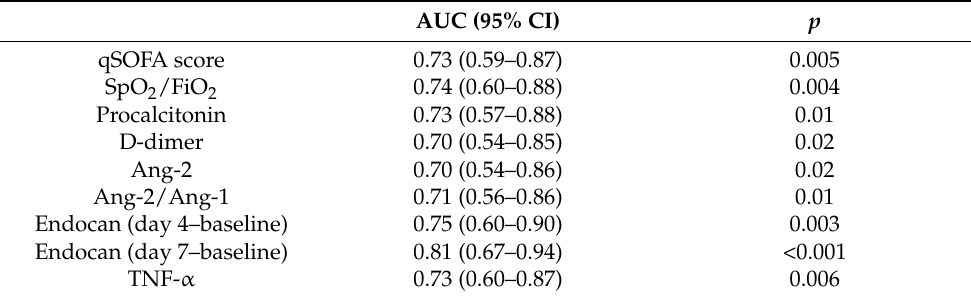
Table 3. Models for predicting failure of liberation from oxygen therapy at day 28 following hospital admission through the top nine performing biomarkers.